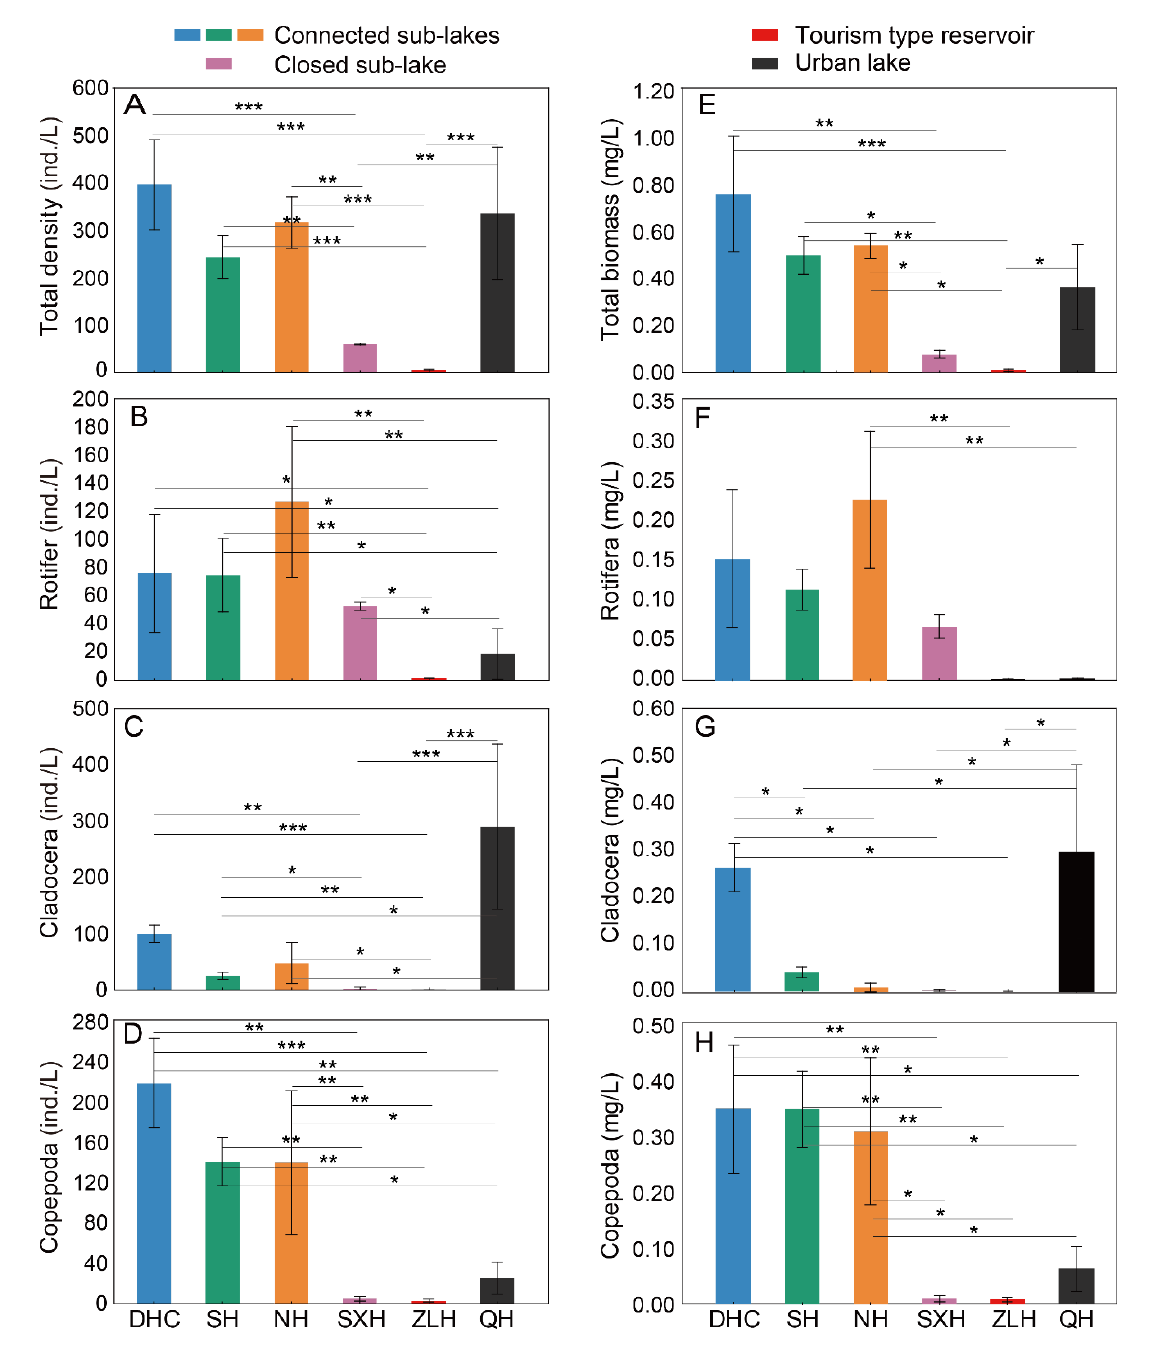
Figure 2. Biomass and density of zooplankton in six sub-lakes. Density (ind./L) of total species ( A ), ( B ) Rotifera, ( C ) Cladocera, ( D ) Copepoda were calculated and biomass (mg/L) of total species ( E ), Rotifera ( F ), Cladocera ( G ), Copepoda ( H ) were calculated. On X- axis, DHC, SH and NH were sub-lakes connected to Poyang Lakes, SXH was closed sub-lake, ZLH was tourism type reservoir and QH was artificial urban lake. The significant differences (* p < 0.05, ** p < 0.01, *** p < 0.001) have been presented in group comparisons.